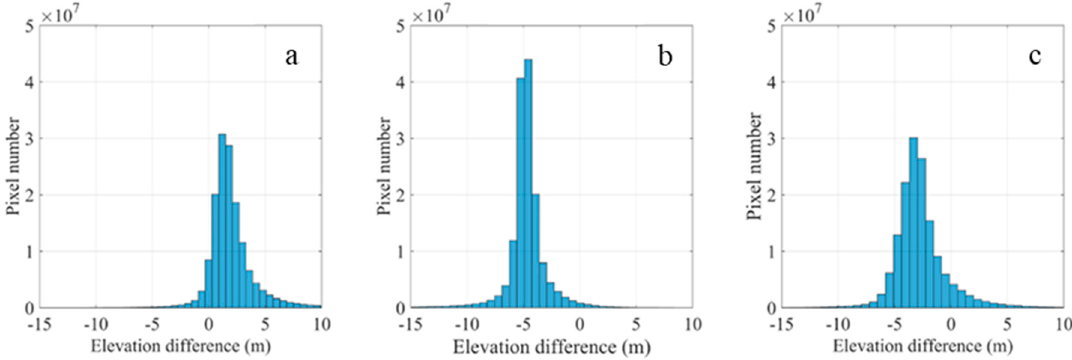
Figure 6. Histogram of surface elevation difference in cold season ( a ), warm season ( b ) and annual scale ( c ) for the Parlung No. 4 Glacier.